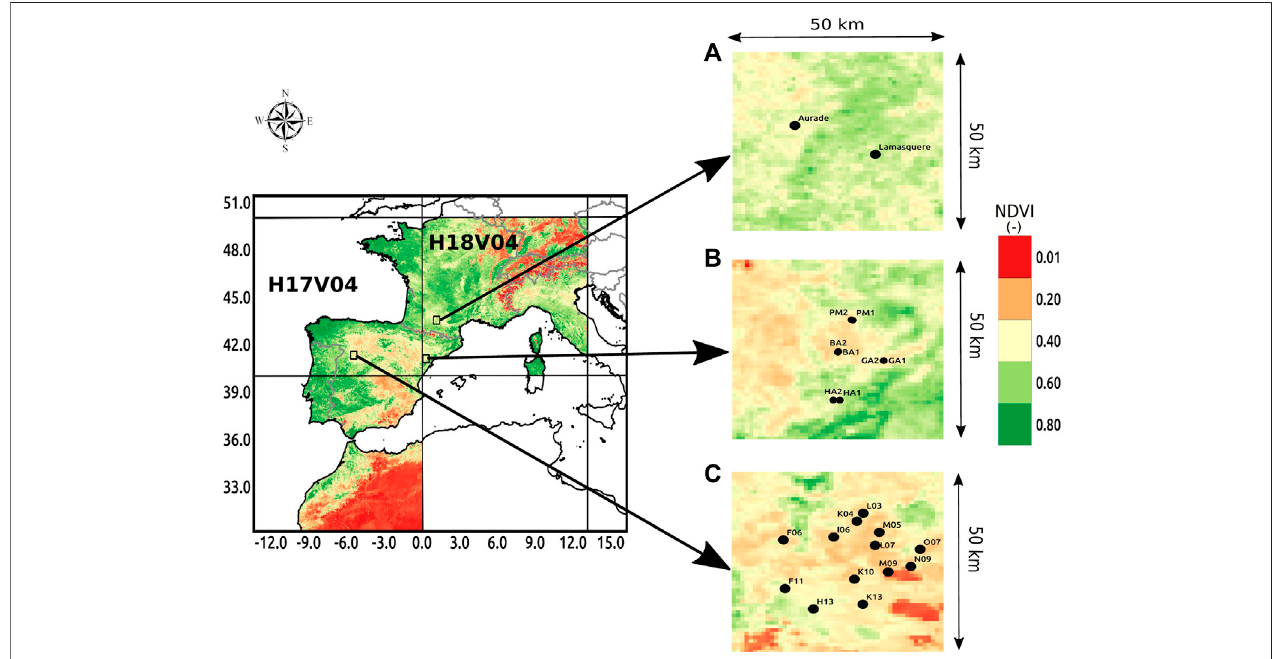
FIGURE 1 | Location of the three study areas: (A) ICOS network in South Western France (B) Dryland network in Eastern Spain and (C) REMEDHUS network in Western Spain.